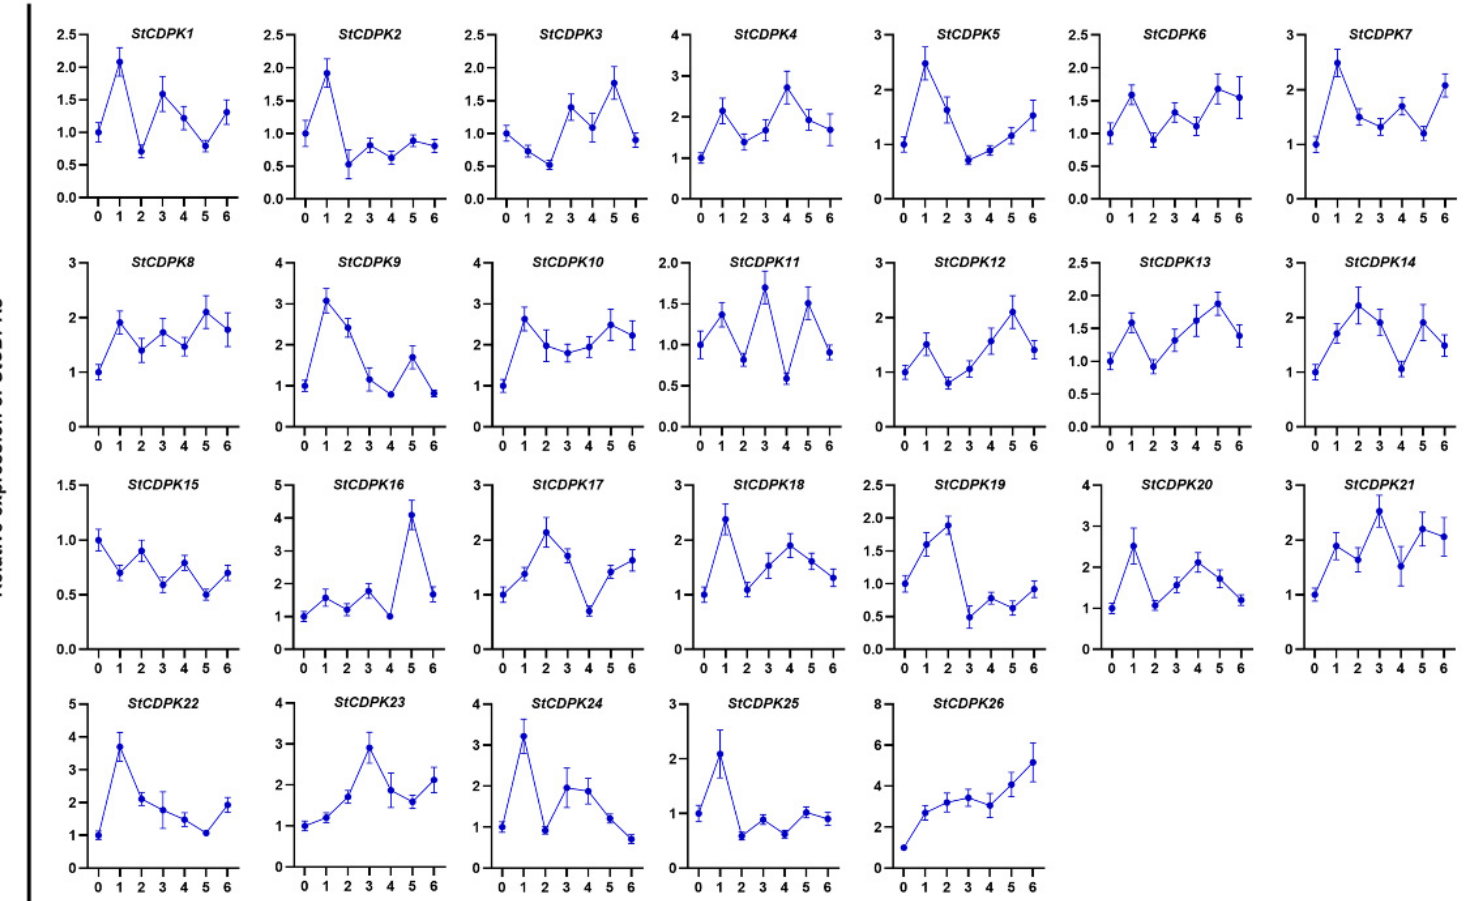
Figure 1. Expression profiles of StCDPKs in potato plants cultivated under severe water deficiency conditions. The mRNA expression of StCDPKs was relatively quantified by qRT-PCR and normalized to StEf1a . Data are presented as the means ± standard deviation of nine replicates.